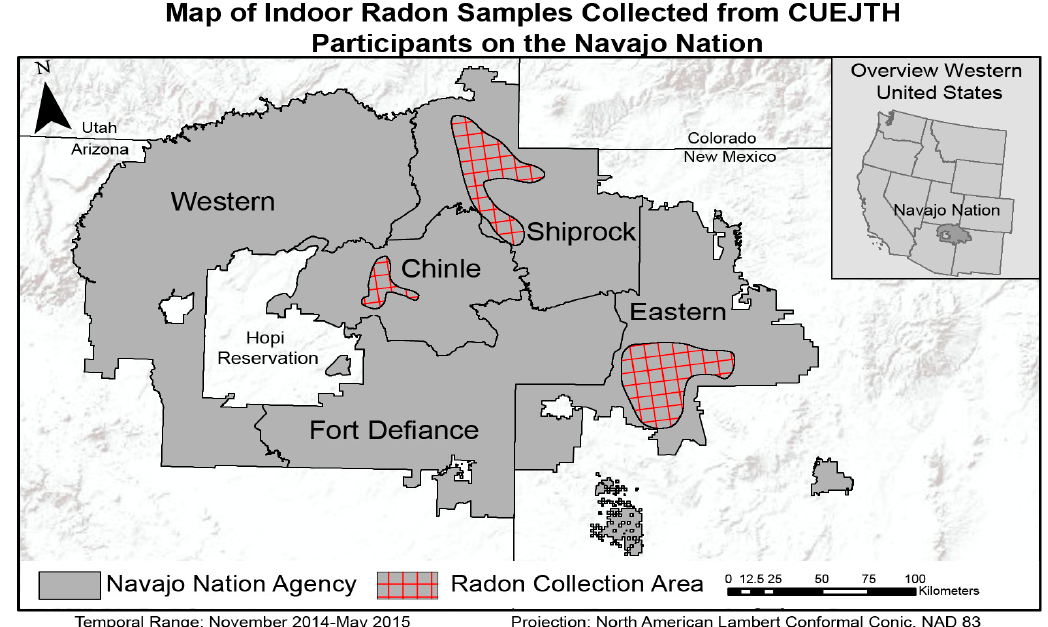
Figure 2. Map of Indoor Radon Samples Collected from CUEJTH Participants (red checkered areas) on the Navajo Nation (Sampling was only conducted in three Navajo Nation Agencies: Shiprock, Chinle, and Eastern).